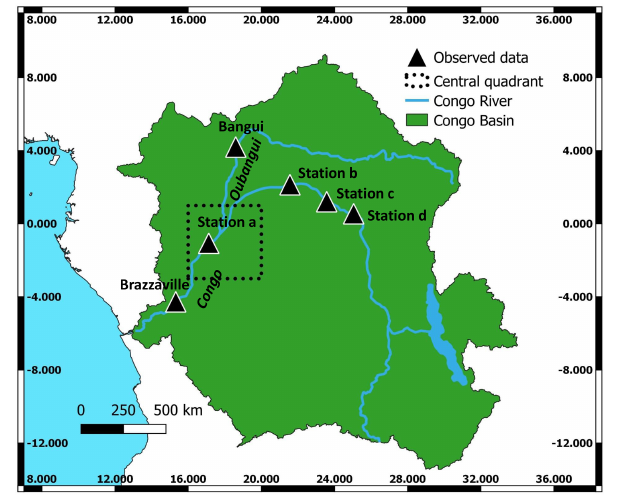
Figure 1. Extent of the Congo Basin, central quadrant of the Cu- vette Centrale, and locations of sampling stations used for validation (of DOC, discharge, and partial pressure of CO 2 ) along the Congo and Oubangui River (in